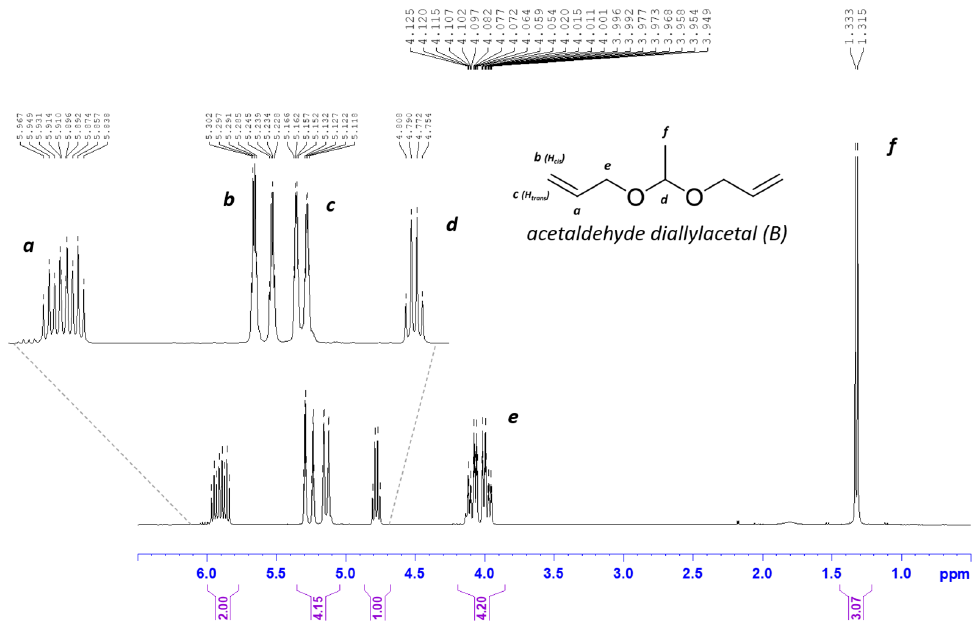
Figure 2. 1 H ‐ NMR of acetaldehyde diallylacetal (B monomer) at 300 MHz in CDCl 3 . Figure 2. 1 H-NMR of acetaldehyde diallylacetal (B monomer) at 300 MHz in CDCl 3